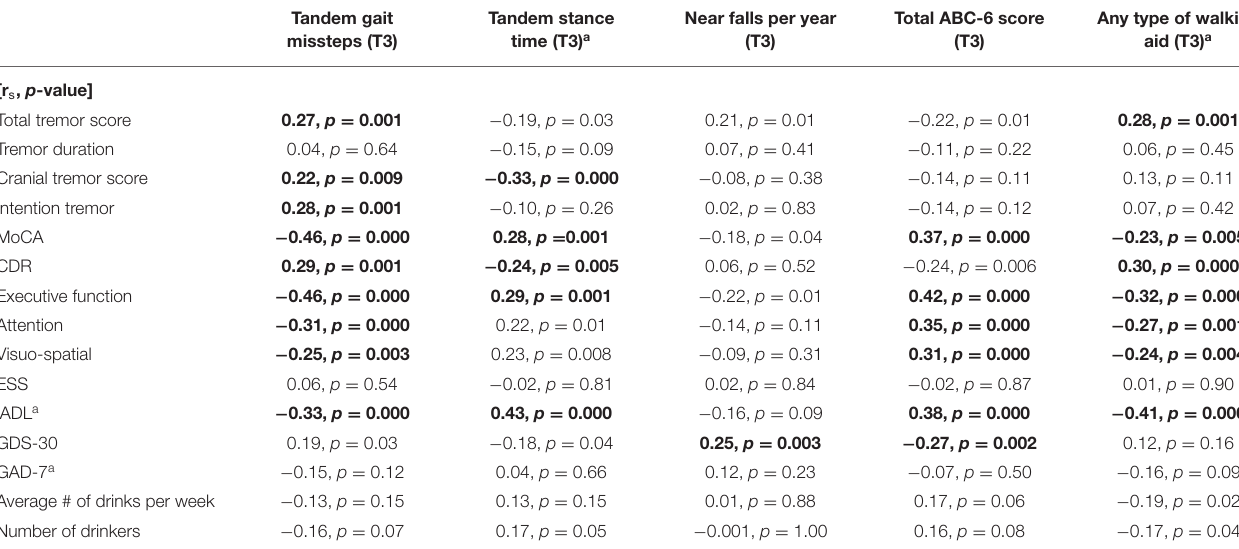
TABLE 3D | Correlational analysis for logistic regression